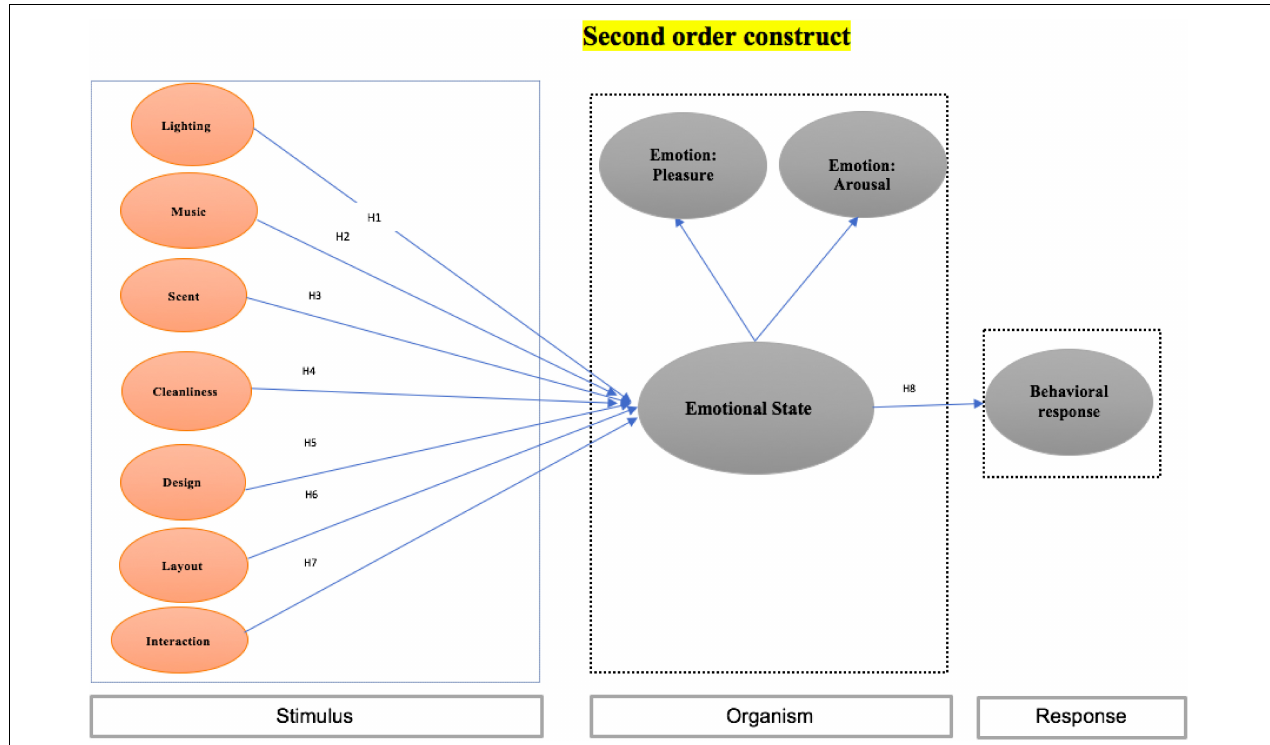
FIGURE 1 | Theoretical